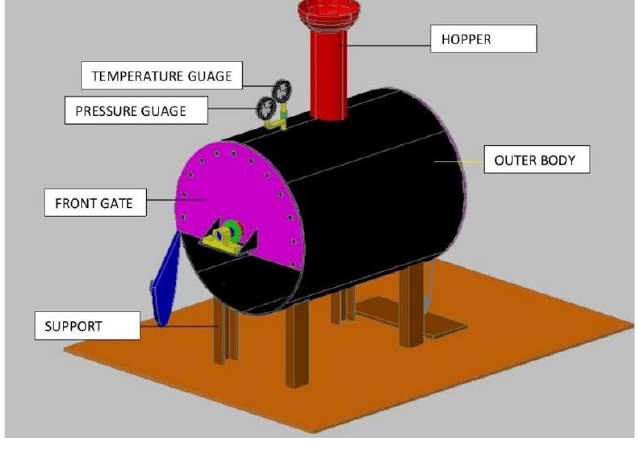
Figure 1: 3D Left side view of composter